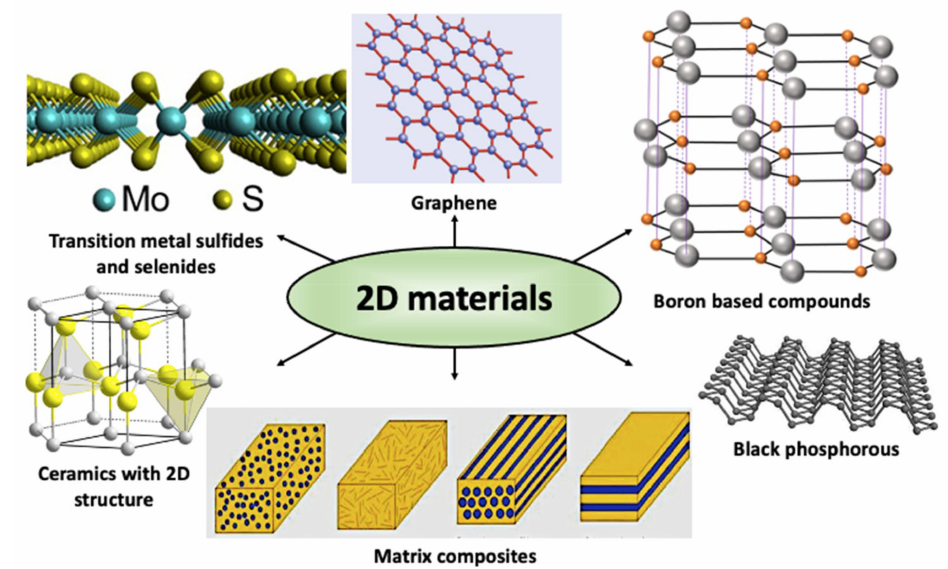
Figure 1. Schematic of different 2D materials covered in this review [19–21].